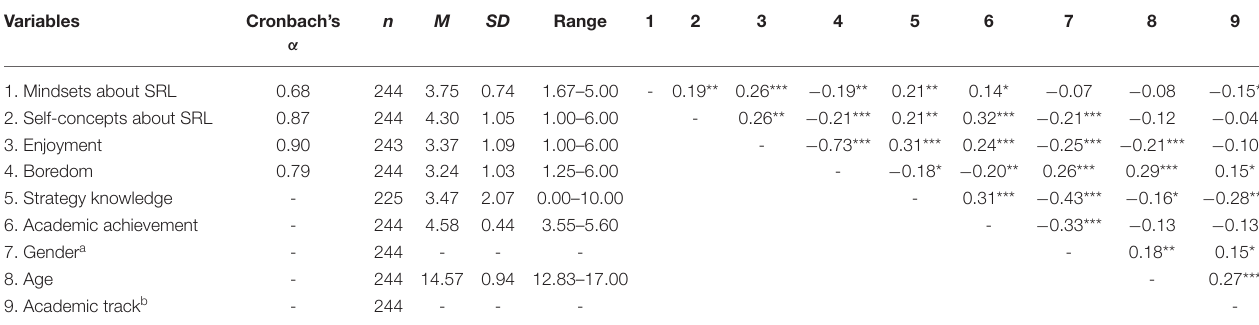
TABLE 1 | Descriptive statistics, internal reliabilities, and correlations.